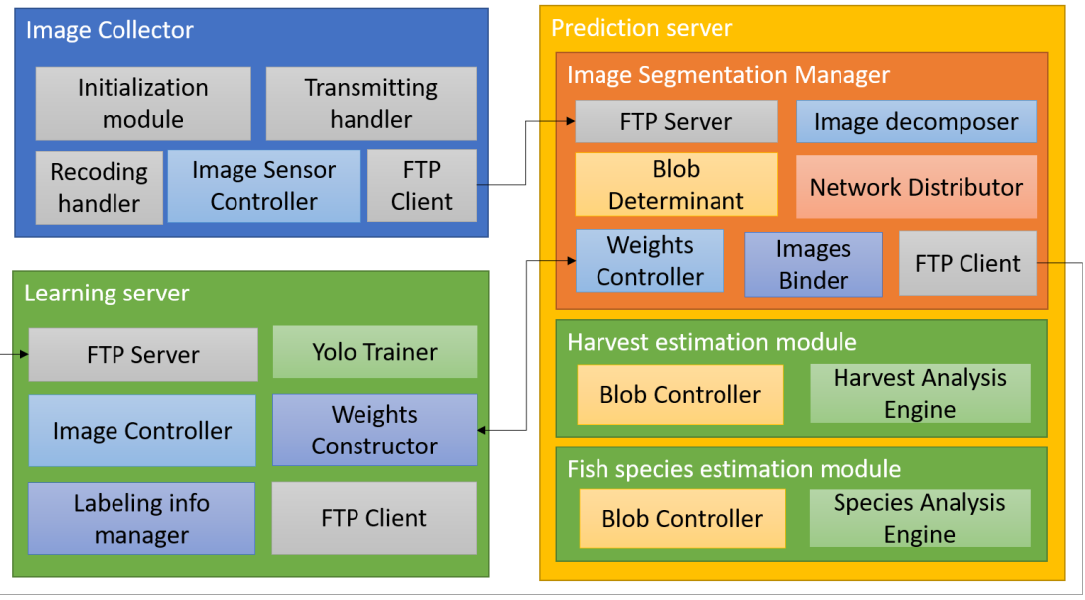
Figure 2. The EM system structure.